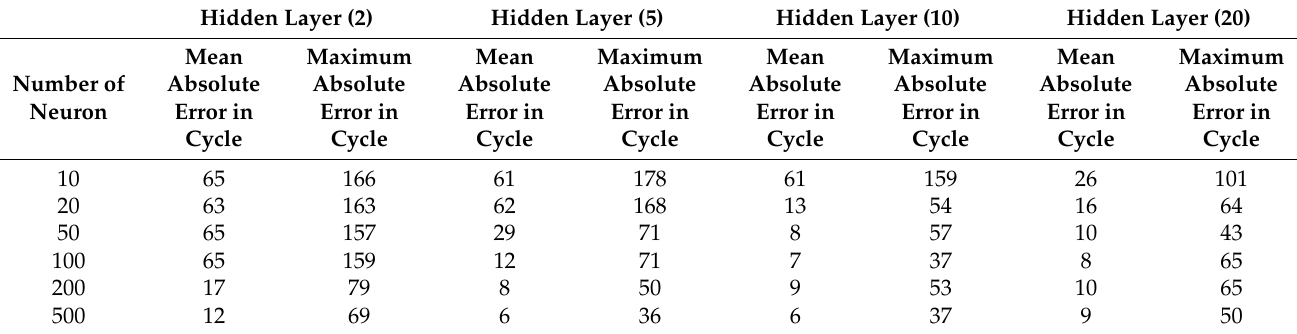
Table 11. Comparison results of FEM and RNN models on 576 training datasets.